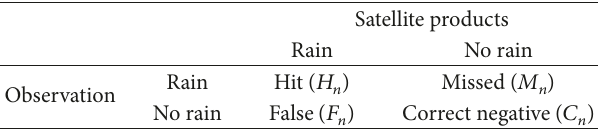
Table 3: Contingency table for comparing observed and satellite- based